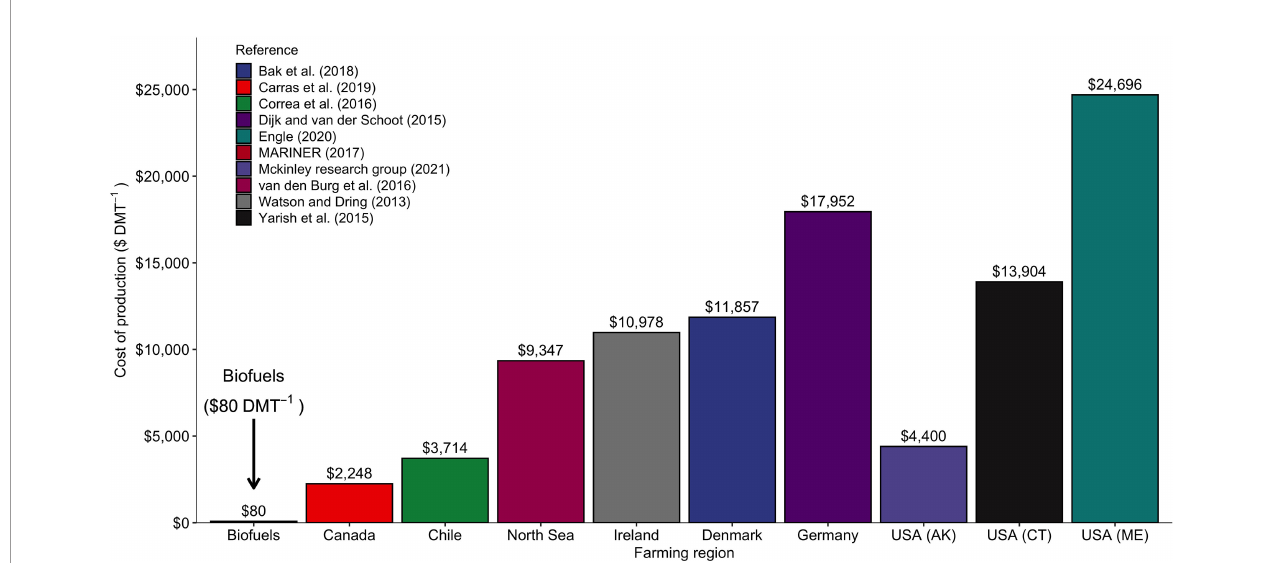
FIGURE 1 | Production costs ($ dry metric ton (DMT) -1 ) estimated from the literature for kelp produced in emerging farming regions around the world. The farm-gate price required for a pro fi table biofuels sector ($80 DMT -1 ) is shown for comparison (ARPA-E,